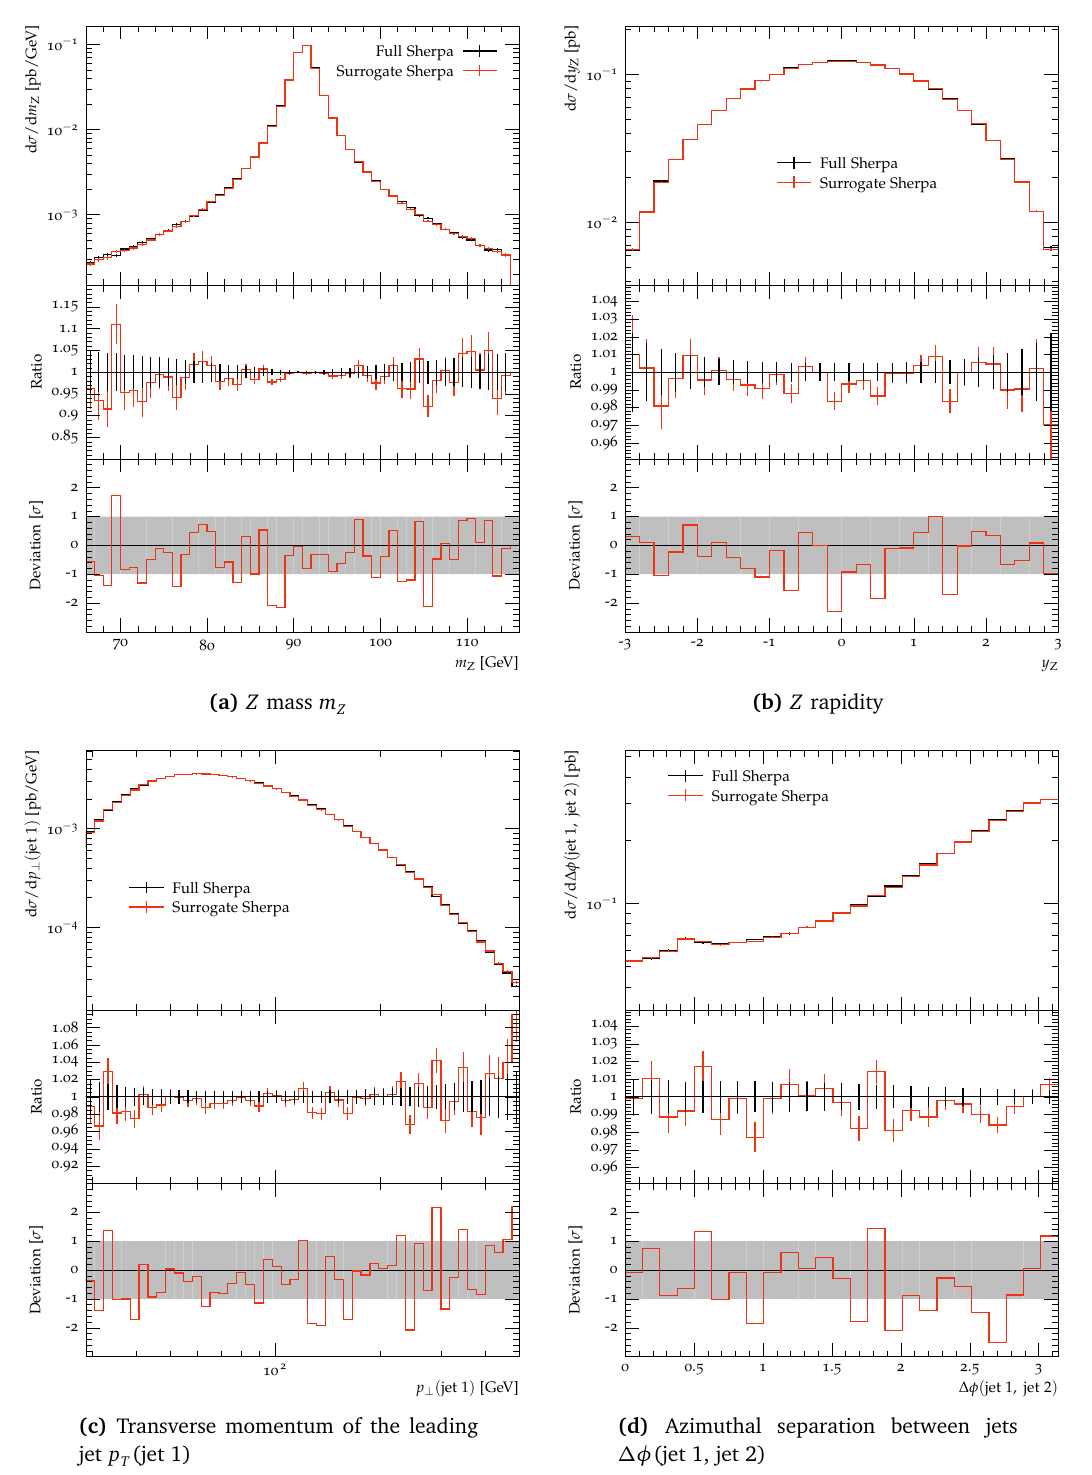
Figure 5: Comparison of different differential distributions generated using S HERPA with (red) and without (black) an NN weight surrogate for the process g g → e − e + g gd ¯ d in proton–proton collisions at